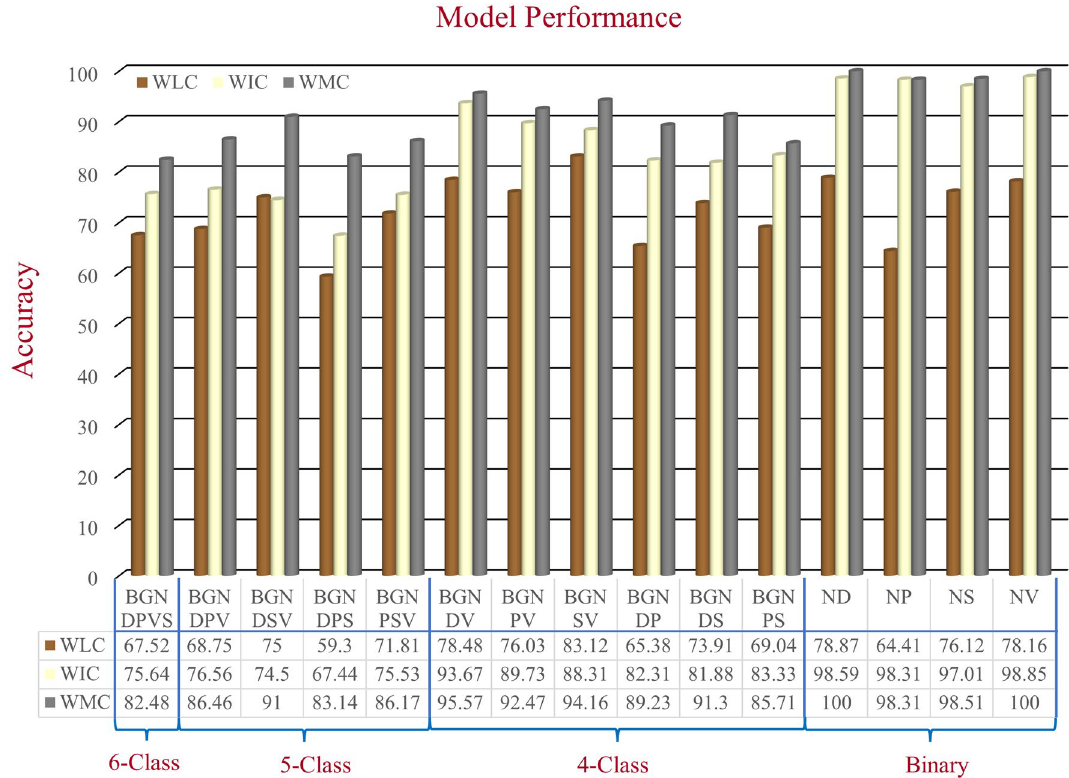
Figure 6. Performance comparison of mixed-class classification among the best models from each category (location—WLC, image—WIC, and multimodality—WMC) on AZH dataset.